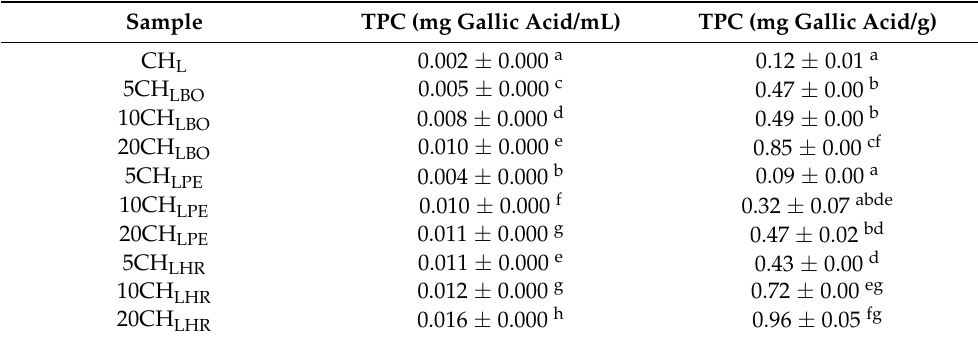
Table 11. Migration—total polyphenols content. Sample